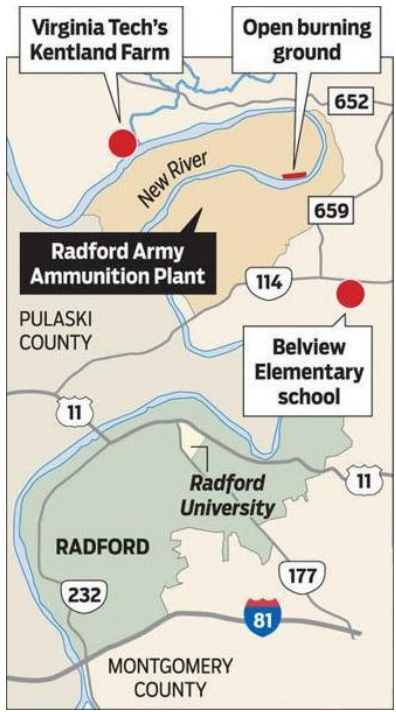
Figure 2. Map of the Radford Army Ammunition Plant and Surrounding Area. Image reproduced courtesy of the Richmond Times-Dispatch [12].